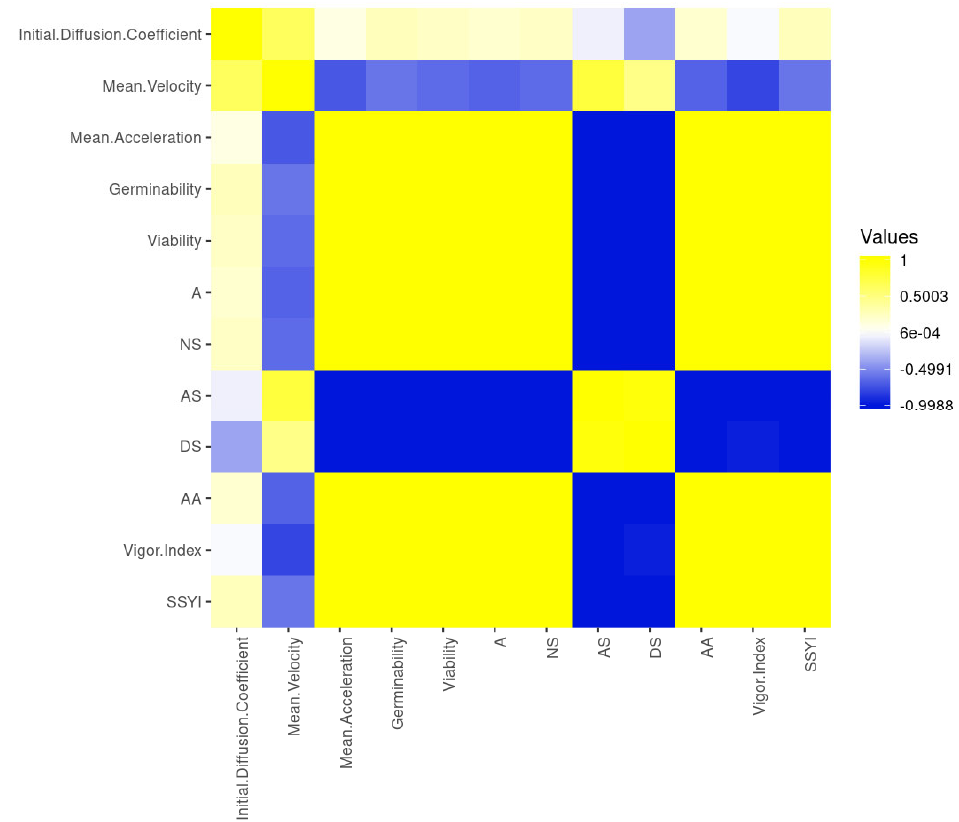
Figure 2. Correlation matrix heatmap based on pair-wise Pearson correlation coefficients (rank correlation; p ≤ 0.01) for germination sensu stricto and post-germination (seedling development) measurements of soybean seeds. Initial diffusion coefficient: D / ρ 2 , h − 1 ; mean velocity: v m , g H 2 O h − 1 ; mean acceleration: a m , g H 2 O h − 2 ; G : germinability (%); V : viability (%); A : Biological Activity in the sample (%); NS : Normal seedlings (%); AS : Abnormal seedlings (%); DS : dead seeds (%); AA : percentage of normal seedlings after accelerate ageing test; Vigor index: SVI = Seedling vigor index (%); SSYI : seed-seedling transition yield index